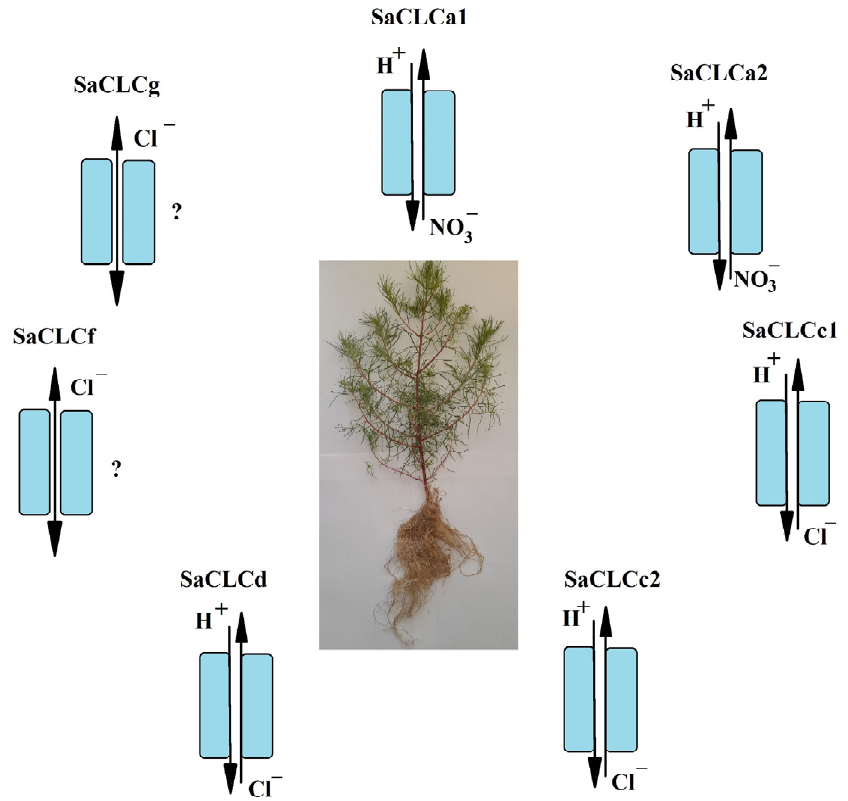
Figure 8. CLC genes/transporters family in Suaeda altissima .